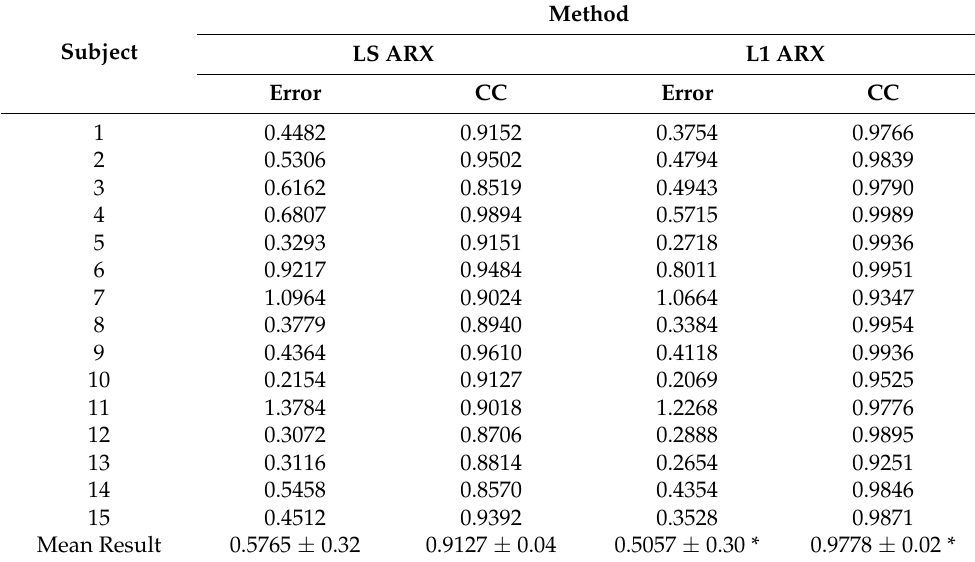
Table 11. The error (mmHg) and correlation coefficient (CC) of the predicted signal with the ARX